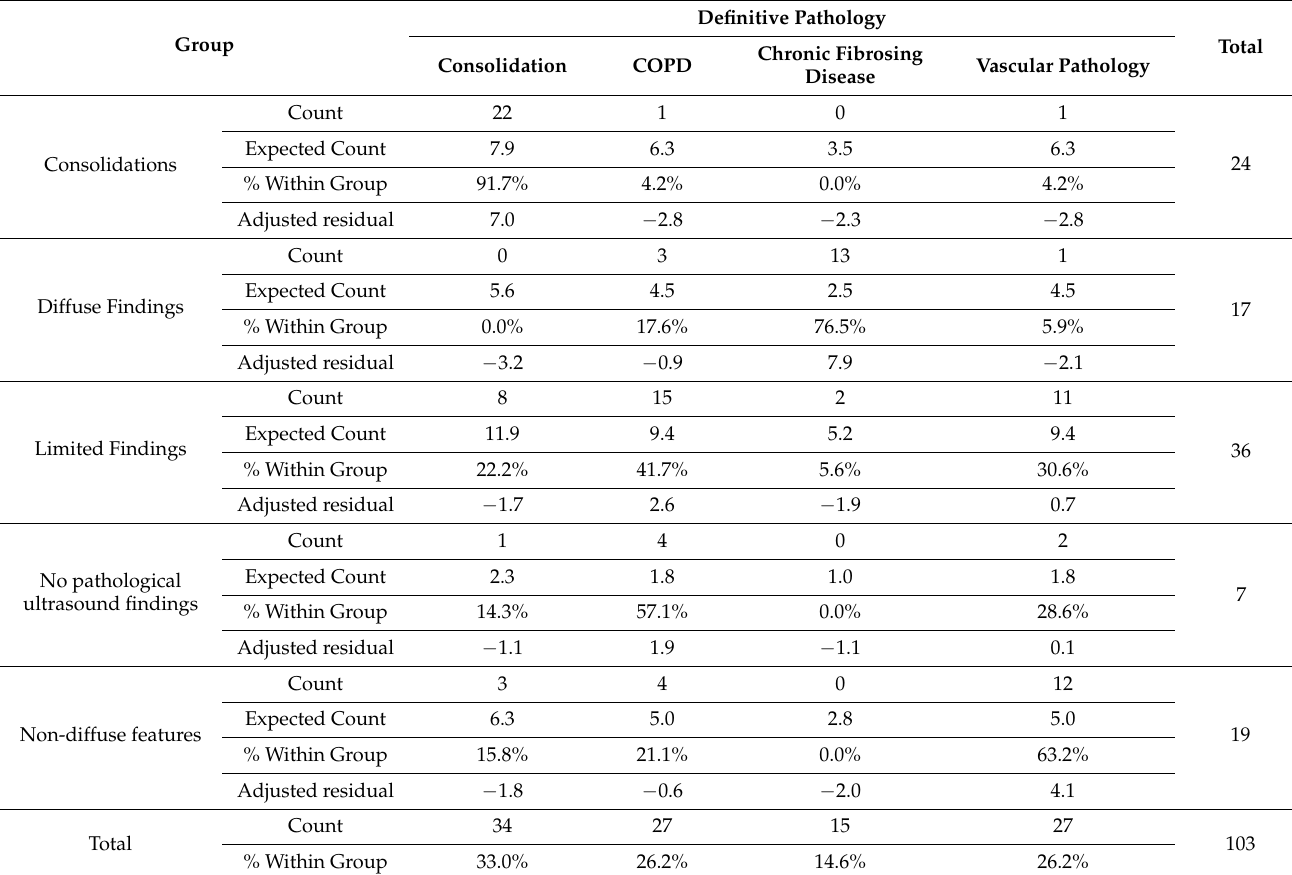
Table 4. Associations between the groups of the patients according to the initial sonographic selection and the four groups of final pathologies described in